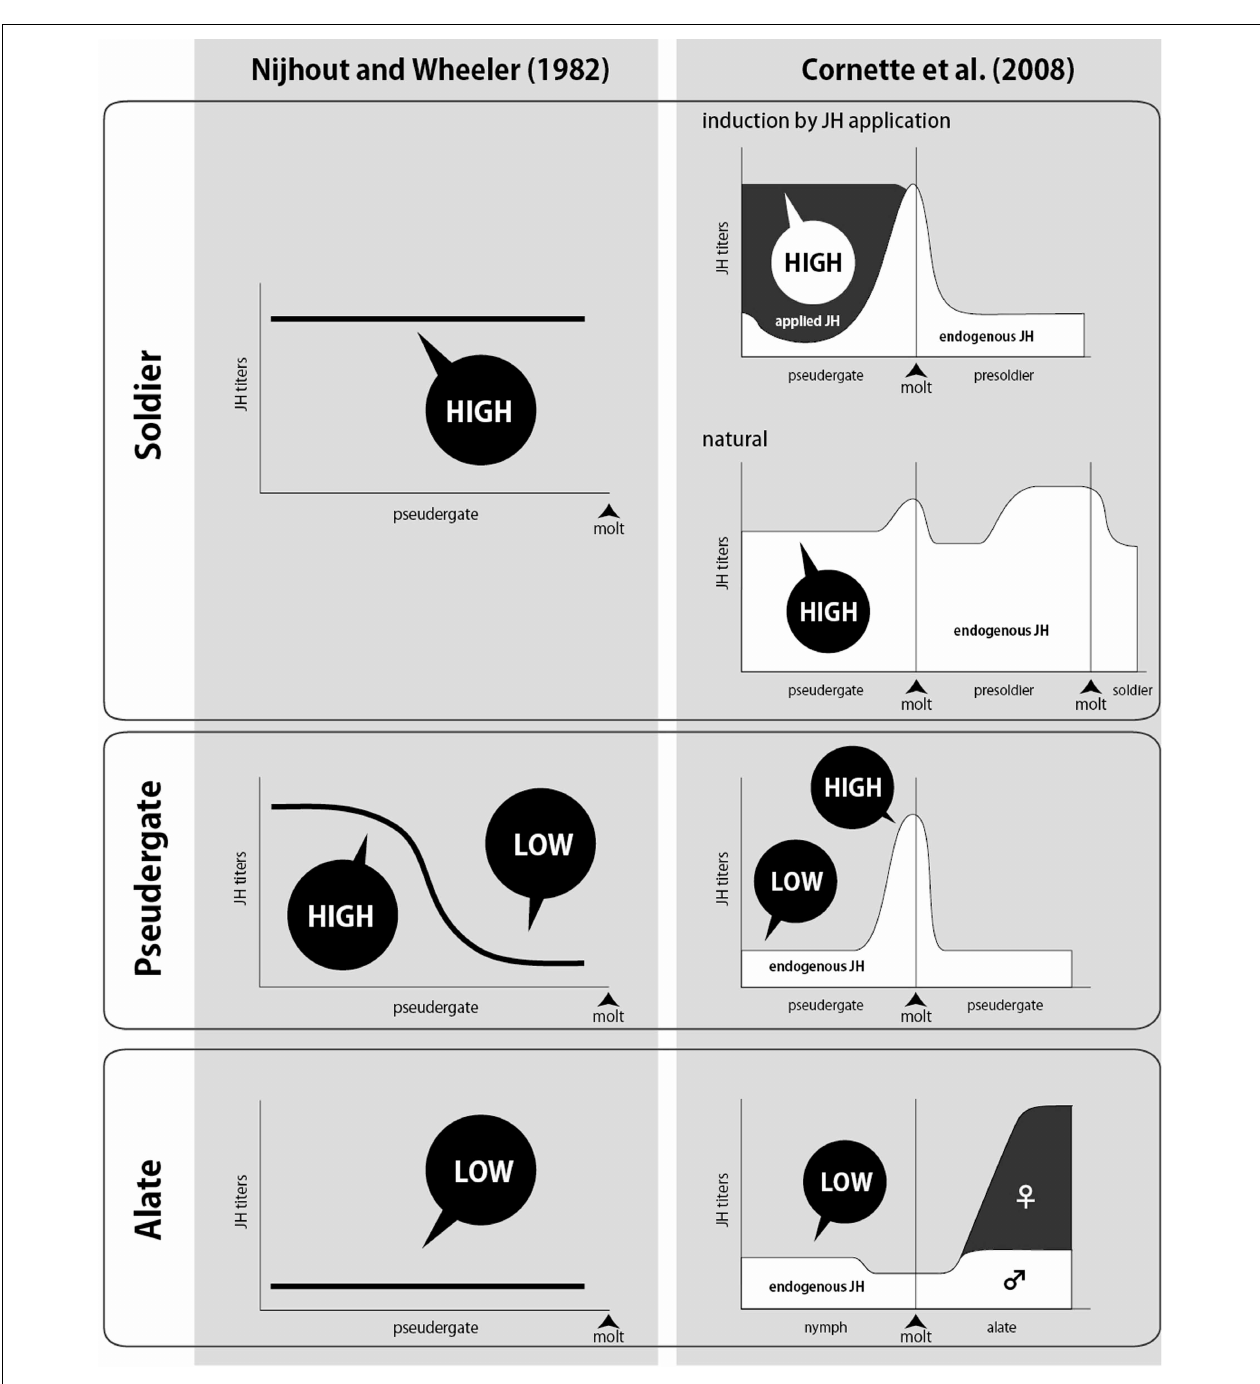
FIGURE 3 | Schematic drawings of classical (Nijhout and Wheeler, 1982; left) and recent (Cornette et al., 2008; right) models on the transitions of JH titer (vertical axis) during intermolt period of pseudergate (horizontal axis) before caste differentiation. Caste names at the far left indicate the future castes determined by the JH